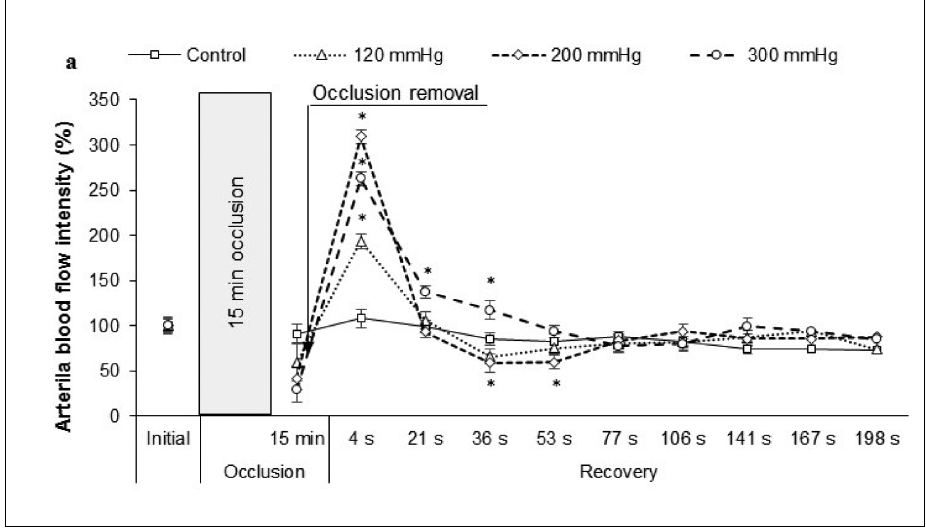
Figure 3. Changes of arterial blood flow in - tensity in experimental groups after removal of 120; 200 or 300 mmHg pressure occlusion and in control group at rest without